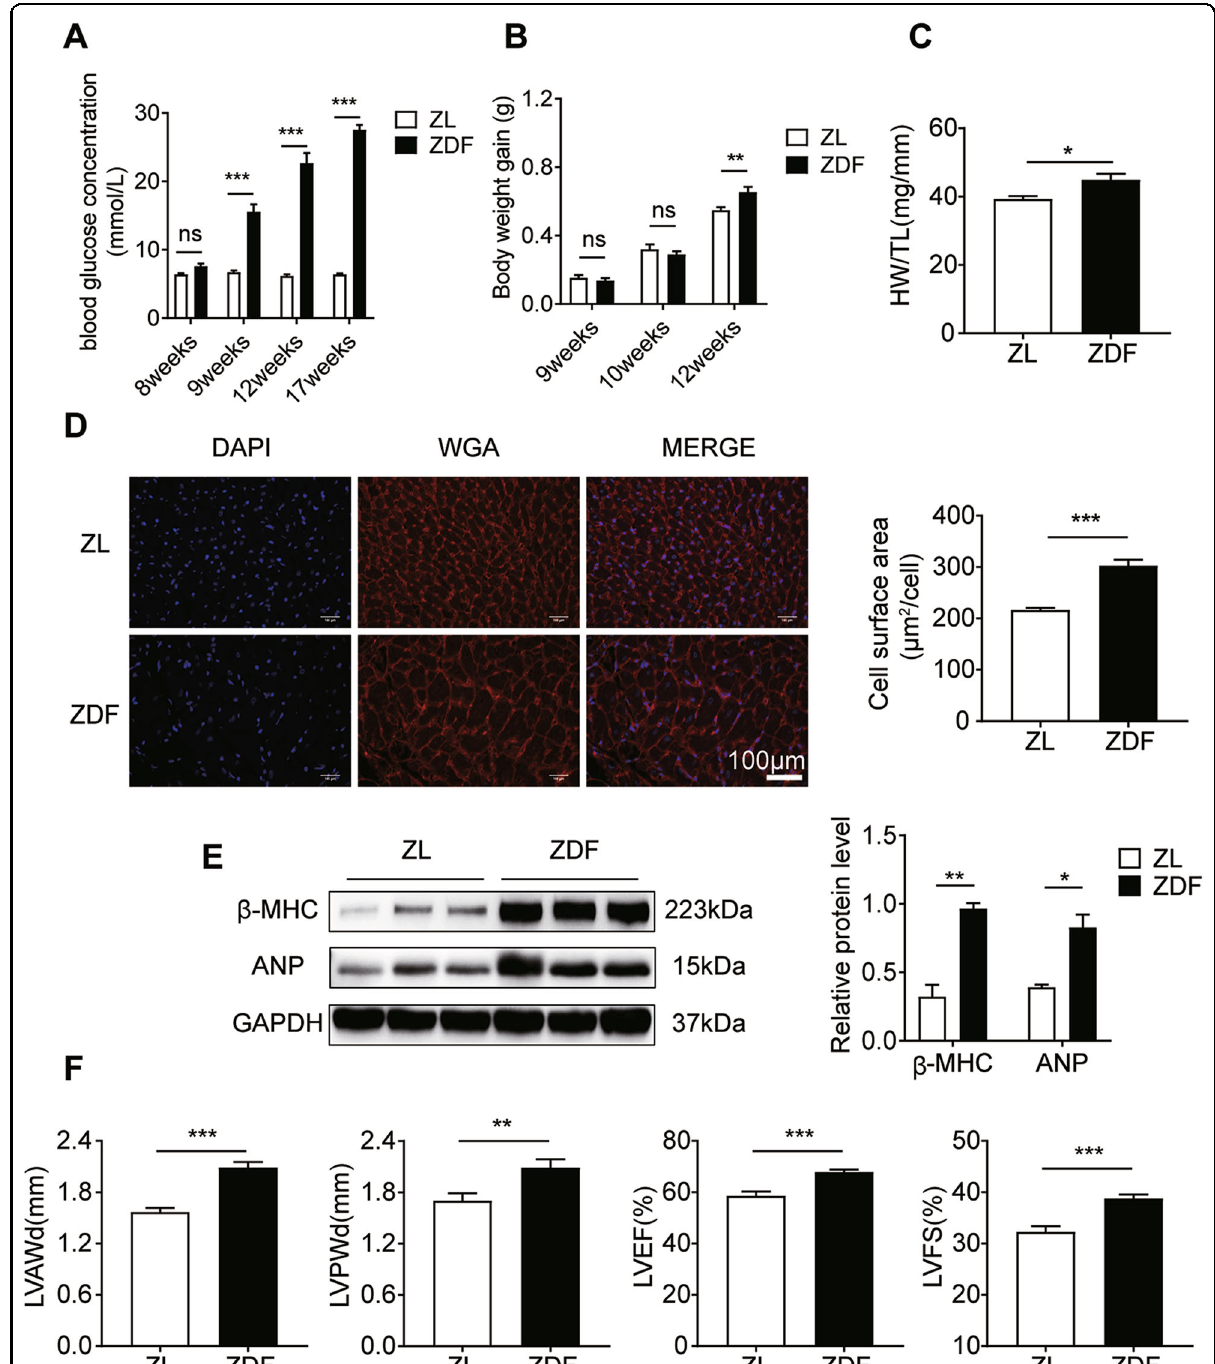
Fig. 1 ZDF rats develop cardiac hypertrophy and exhibit impaired cardiac function. A Blood glucose at various time points ( n = 10). B Body weight gain (g) = ( fi nal body weight − initial body weight)/initial body weight ( n = 10). C Heart weight/tibia length (HW/TL, g/mm) ratio ( n = 9). D WGA staining (red) of the surface membrane of cardiomyocytes, and DAPI staining (blue) of nuclei, scale bars = 100 μ m. Quanti fi cation of the surface area of cardiomyocytes by WGA staining ( n = 10). E Western blotting images and summarized data showing ANP and β -MHC levels in the ventricular tissue of ZL and ZDF rats ( n = 6). F Echocardiographic parameters of each group of rats ( n = 10). Data are shown as mean ± SEM. * P < 0.05, ** P < 0.01, and *** P < 0.001 vs ZL